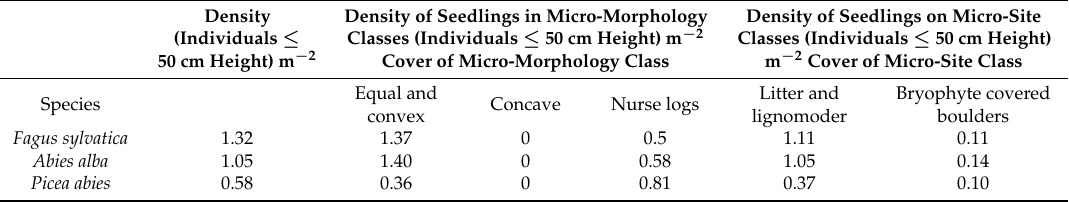
Table 1. Densities of tree seedlings in different micro-morphology-types and micro-site classes. Density (Individuals